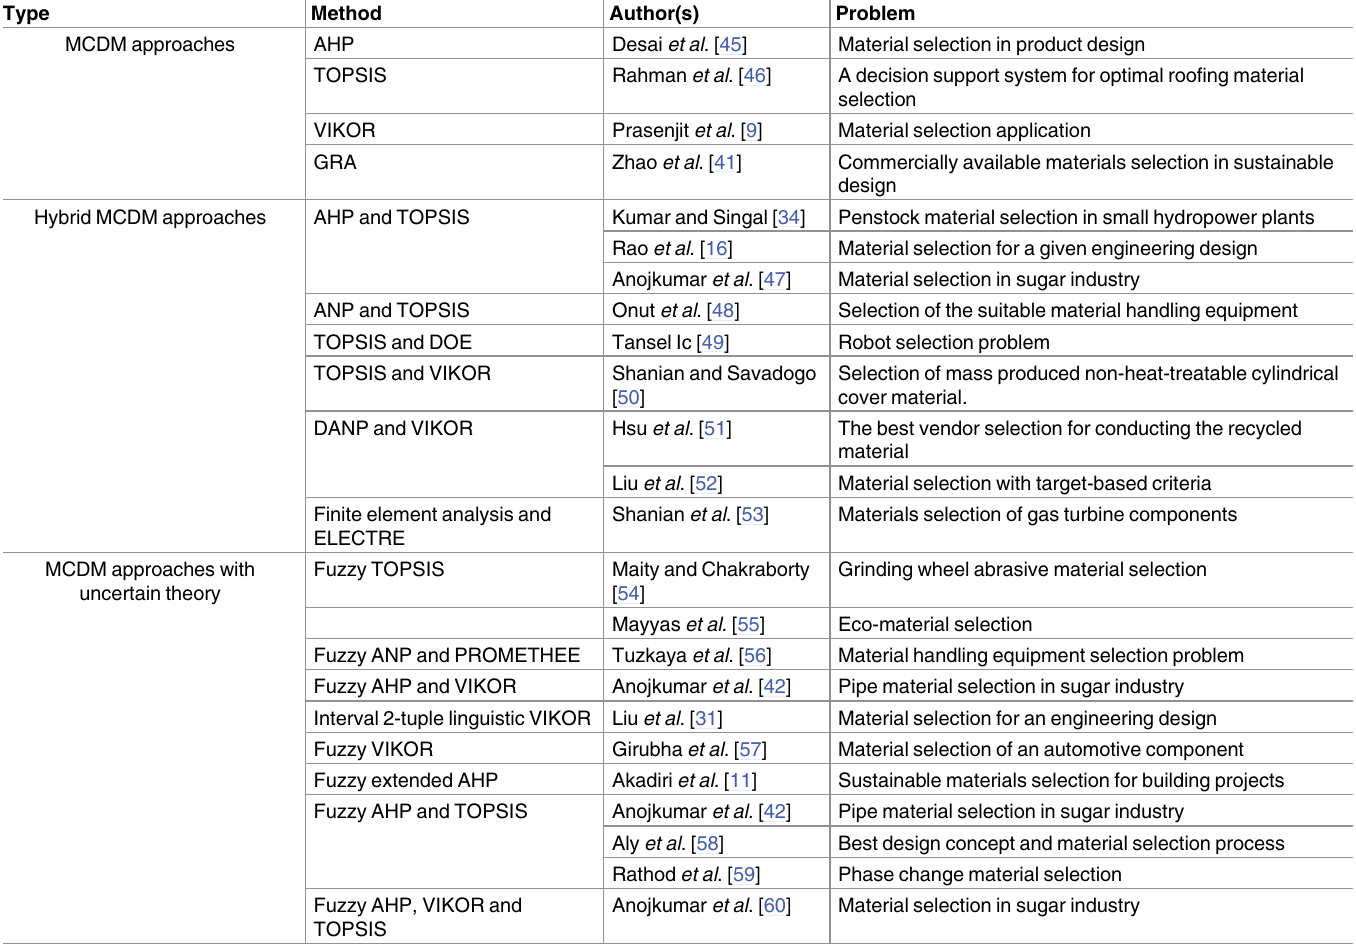
Table 1. Applications of MADM methods for material selection in different